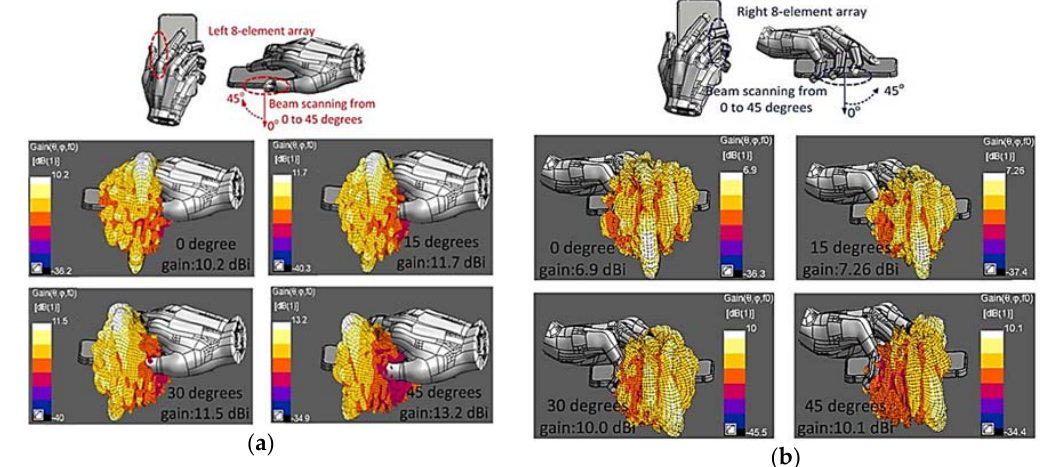
Figure 14. ( a ) Effects of user’s body on the proposed eight ‐ element phased array with different beam ‐ scanning angles positioned on the left side of mobile terminal. ( b ) User body effects on the eight ‐ element phased array located along the right edge of mobile terminal at different beam ‐ scanning angles. (Redrawn from [41])